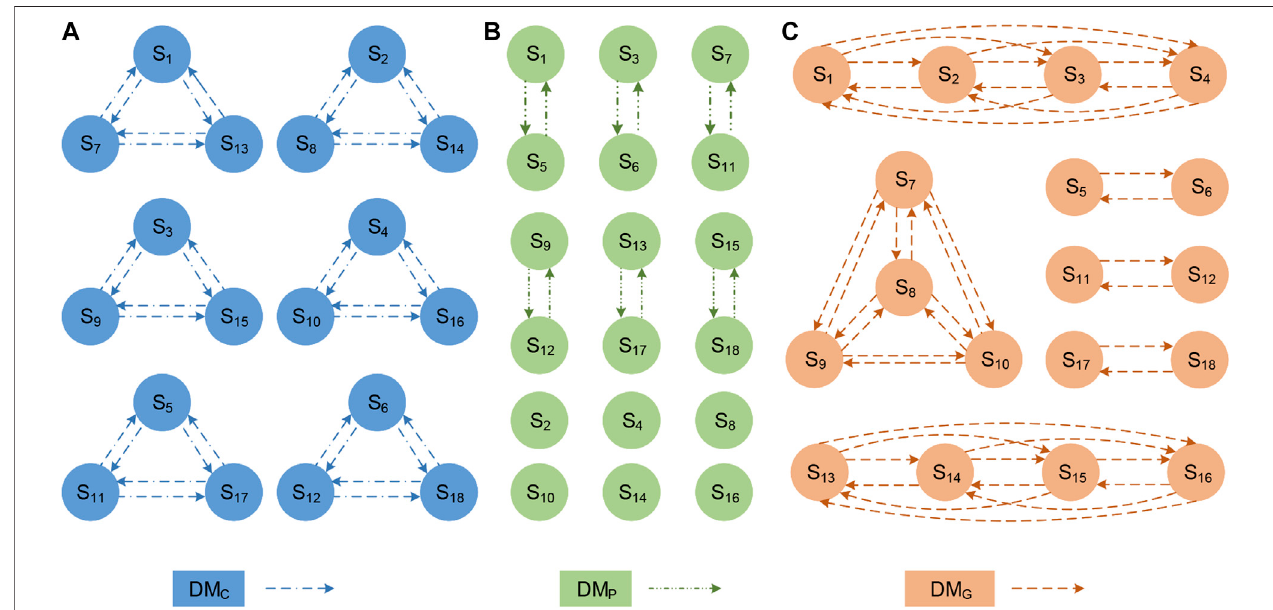
FIGURE 3 | Feasible state transfer of ternary con fl ict in coal- fi red power industry chain.